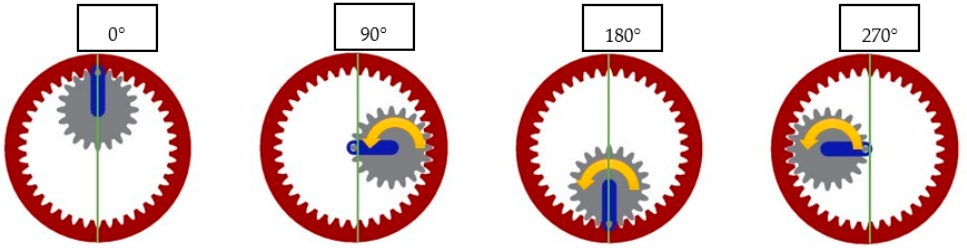
Figure 5. Principle of operation of a hypocycloidal gear.